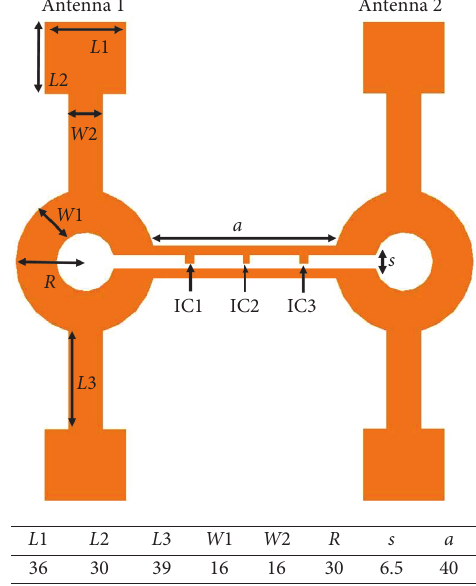
Figure 1: Platform design with dimensions (mm).